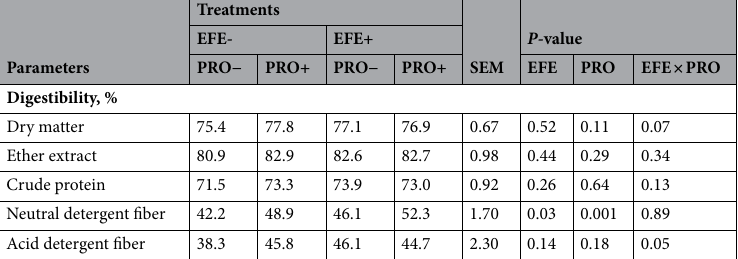
Table 6. Least squares means for digestibility in dairy calves supplemented with or without exogenous fibrolytic enzymes (EFE) and probiotic (PRO) in the starter diets (n = 12 calves per treatment). Treatments were (1) calves fed diets without exogenous fibrolytic enzymes (EFE)-treated wheat straw and probiotic supplement (EFE-Pro−), (2) calves fed diets of EFE-treated wheat straw but with probiotic supplement (2 g/d/calf; EFE-Pro+), (3) calves fed EFE-treated wheat straw (2 g/d/calf) but without probiotic supplement (EFE+ Pro−), (4) calves fed EFE-treated wheat straw and probiotic supplement (EFE+ Pro+). Exogenous fibrolytic enzymes were applied to wheat